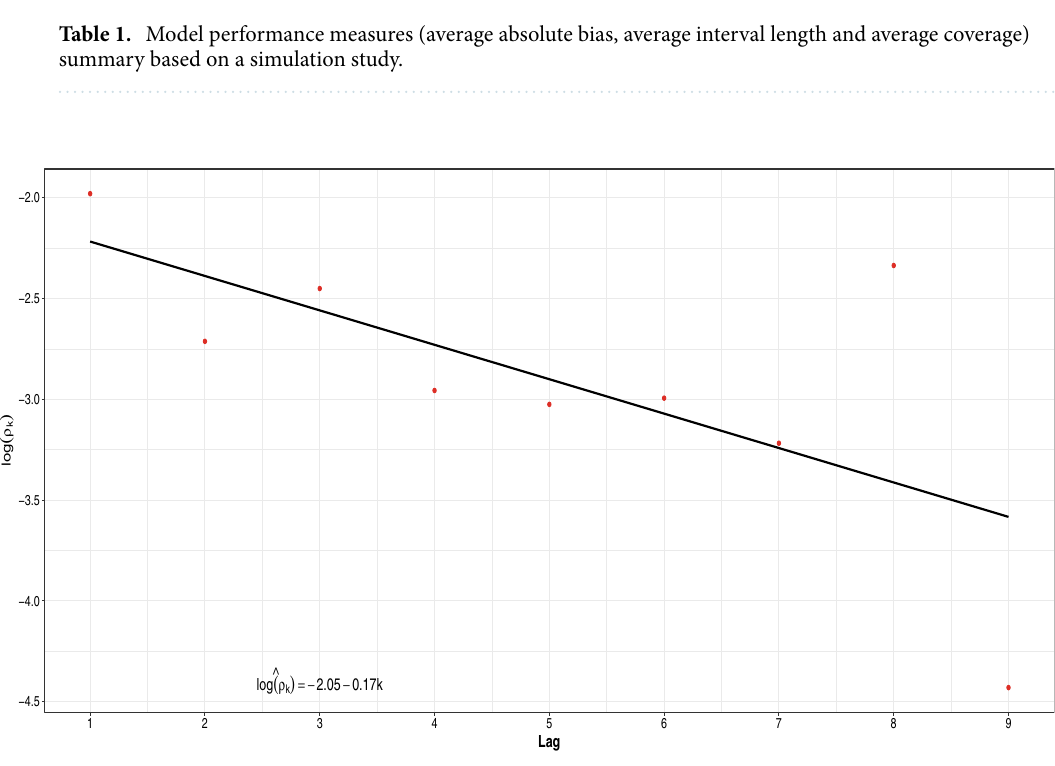
Figure 1. Sample autocorrelation coefficients (red points) and estimated regression line (black solid line) of log (ρ Y ( k )) = log ( c ) + k · log (α)